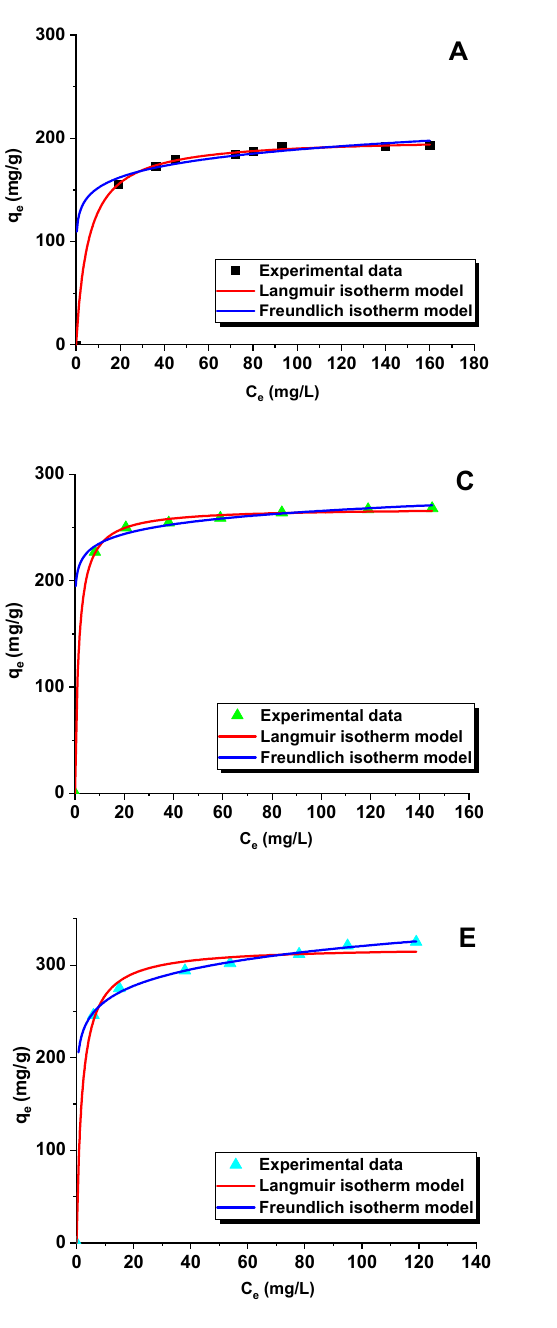
Figure 9. Non-linear fitting of rhodamine B adsorption isotherms to Langmuir and Freundlich models for samples: C SBA-15 ( A ), C SBA15 -0.5-70 ( B ), C SBA-15 -5-70 ( C ), C SBA-15 -0.5-100 ( D ), and C SBA-15 -5-100 ( E ). Table 5. The parameters of linear form of Langmuir and Freundlich models for rhodamine B ad- sorption onto carbon materials.